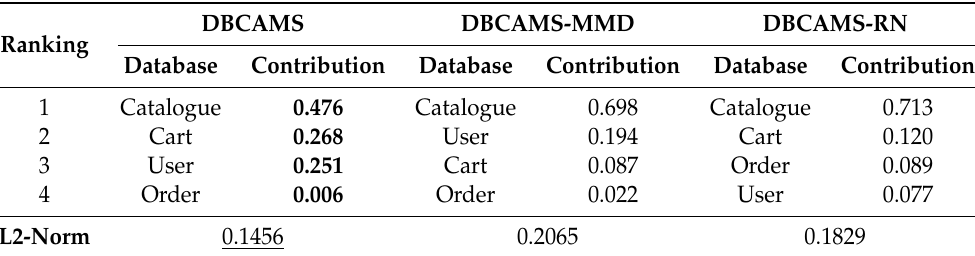
Table 10. The main results of Sock-Shop. The best result of L2-Norm is underlined, and the databases’ contributions of the corresponding method are bold. ( ( α , β , γ , δ ) = ( 2,4,1,3 ) ). Ranking